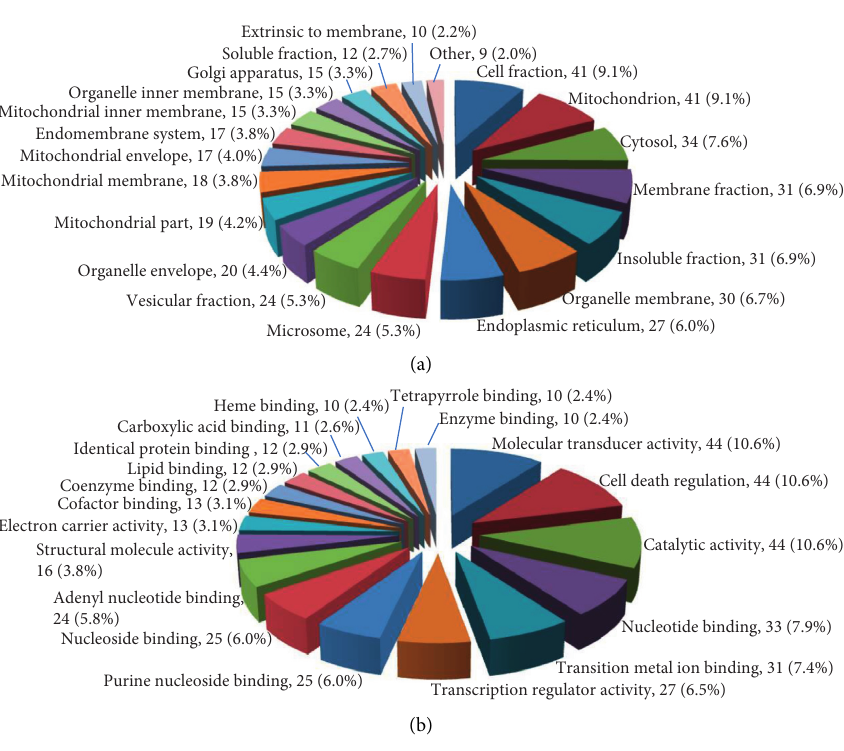
Figure 3: GO analysis of differential expression proteins. (a) Cellular component. (b) Molecular function. Table 2: Regulated proteins related to apoptosis identified by LC-MS/MS and UniProt